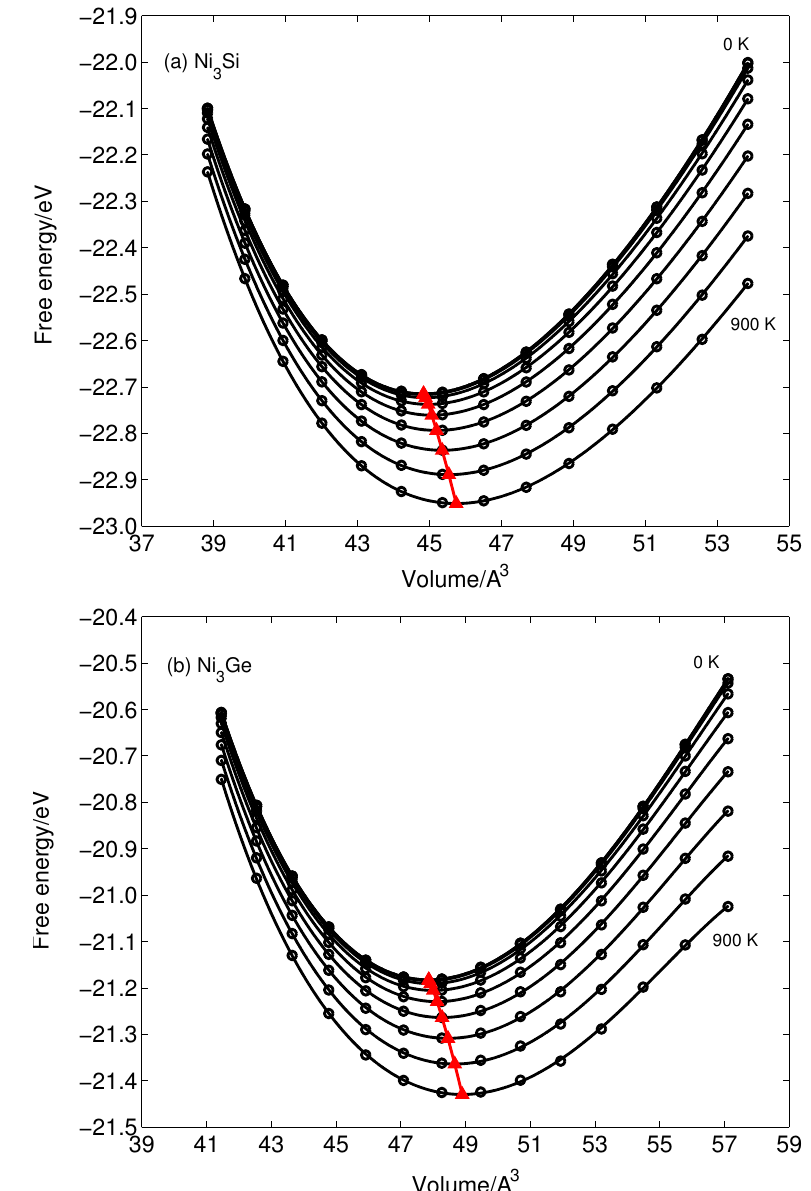
Figure 2. The values of Helmholtz free energy as a function of unit cell volume of ( a ) Ni 3 Si and ( b ) Ni 3 Ge at every 100 K between 0 and 900 K. The red triangles indicate the corresponding equilibrium volumes at